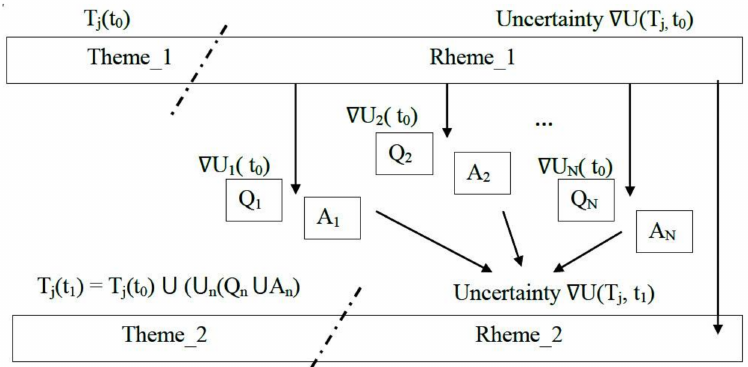
Figure 15. Reducing the uncertainty of textual